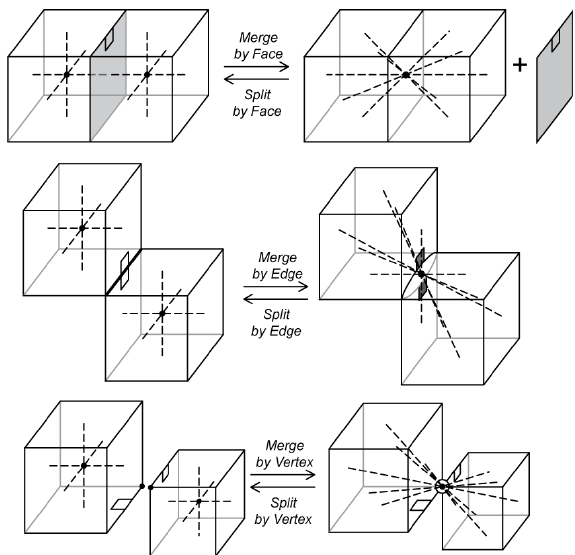
Figure 16. Merge/Split operators for cell complex construction.